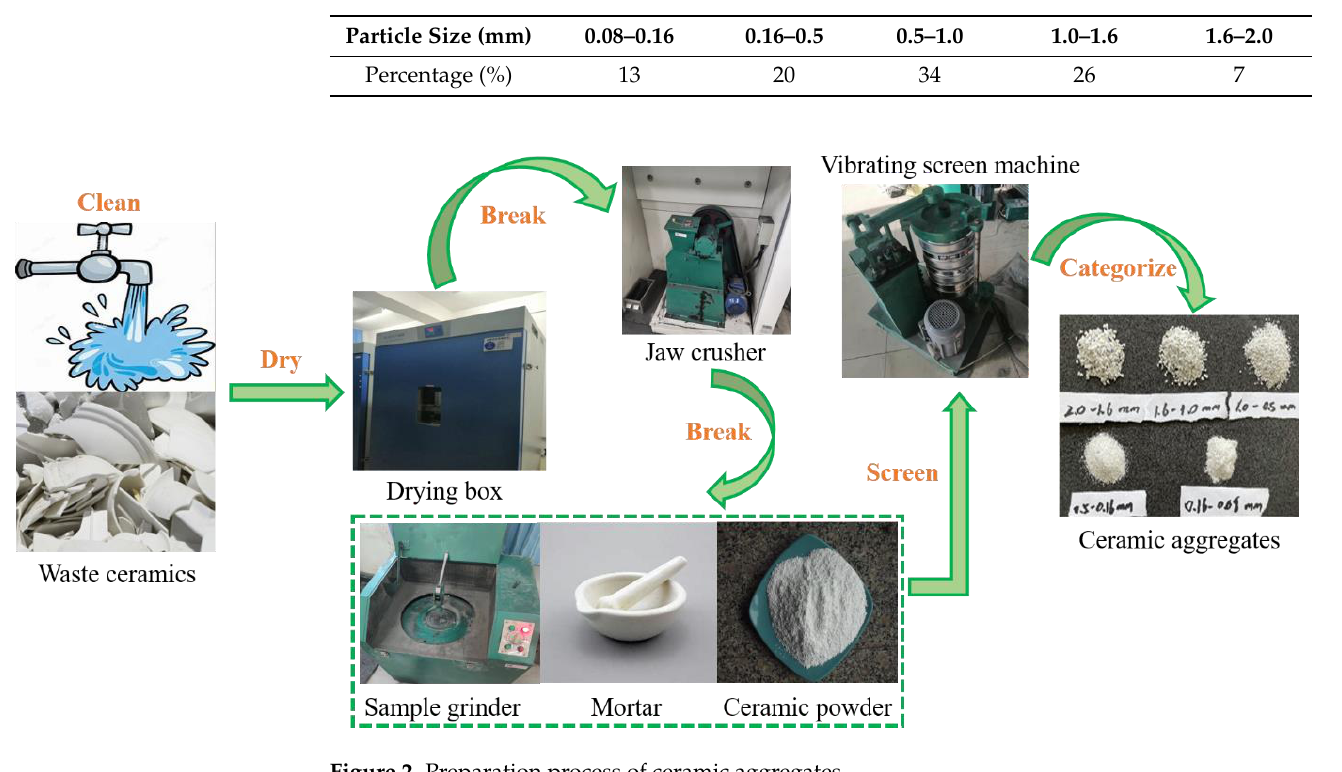
Figure 2. Preparation process of ceramic aggregates.